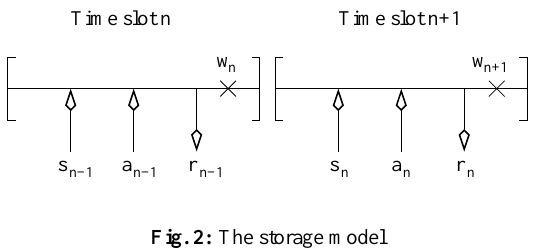
Fig. 2: The storage